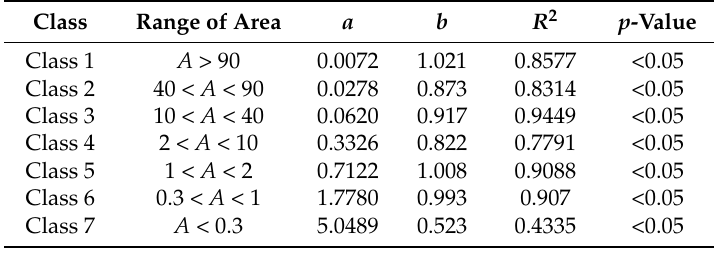
Table 2. Results of nonlinear regression analysis between D d and L t for seven classes of patch areas.